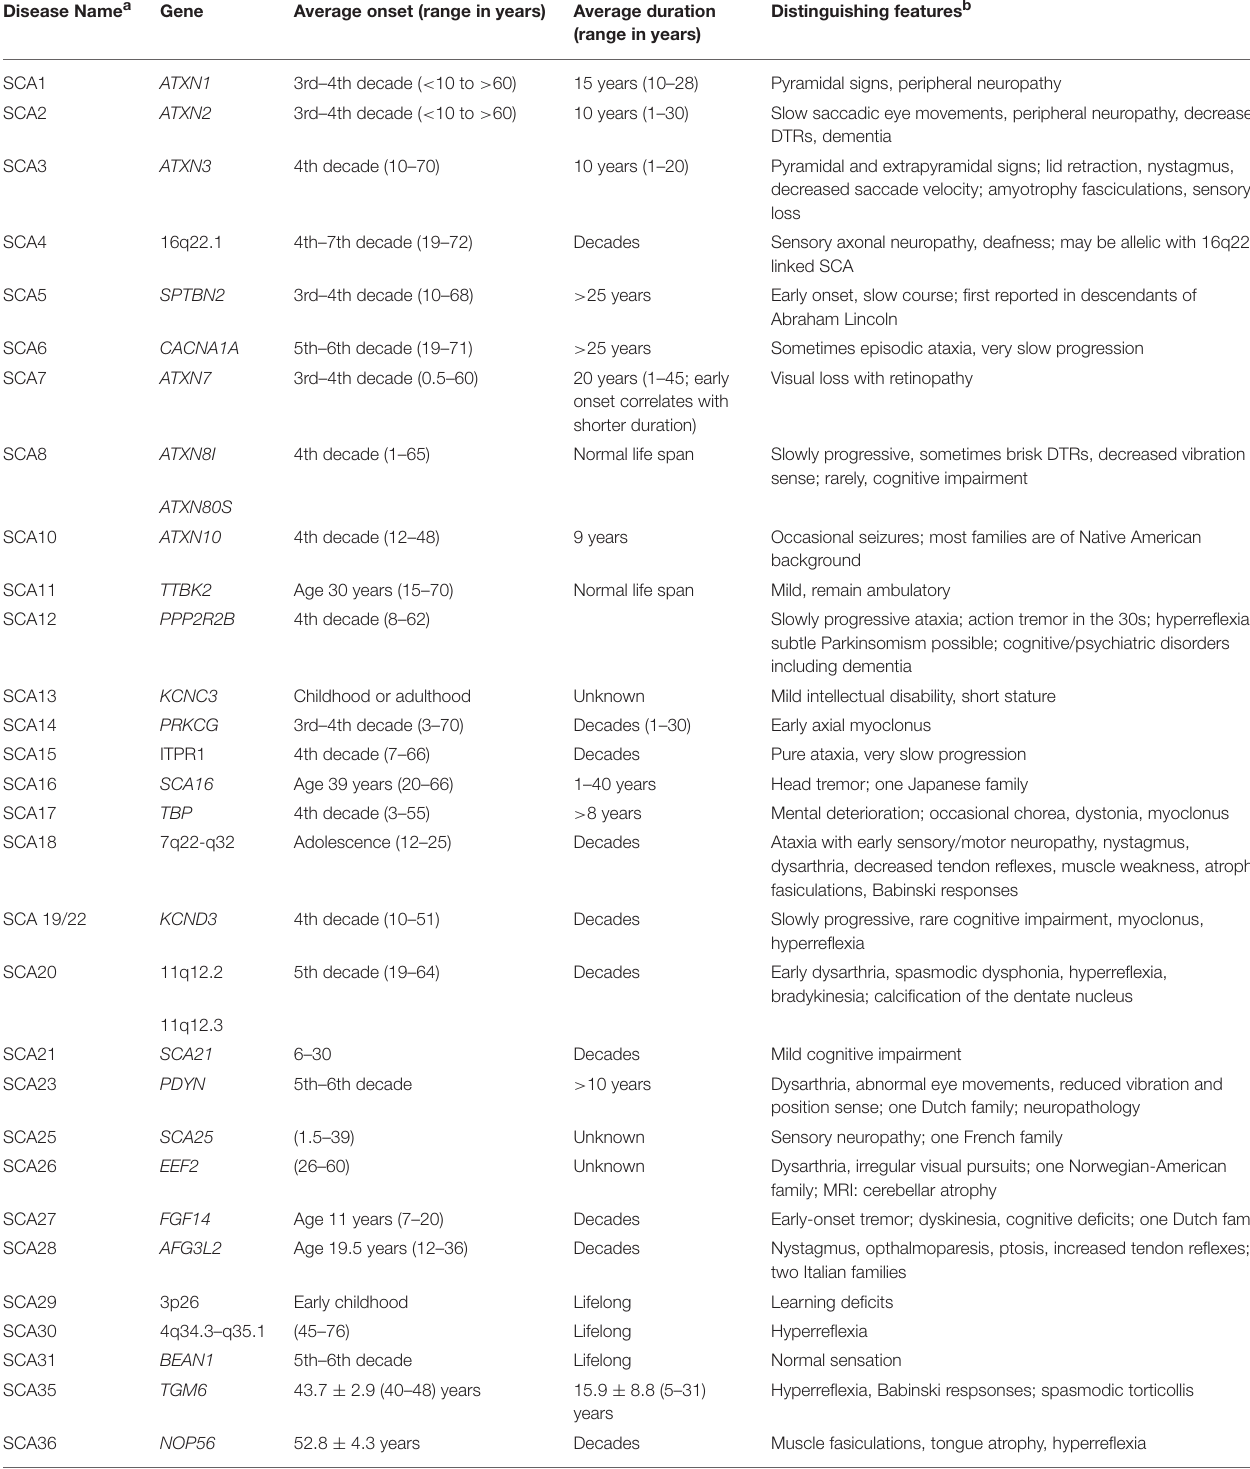
TABLE 1 | Autosomal dominant hereditary ataxias. Disease Name